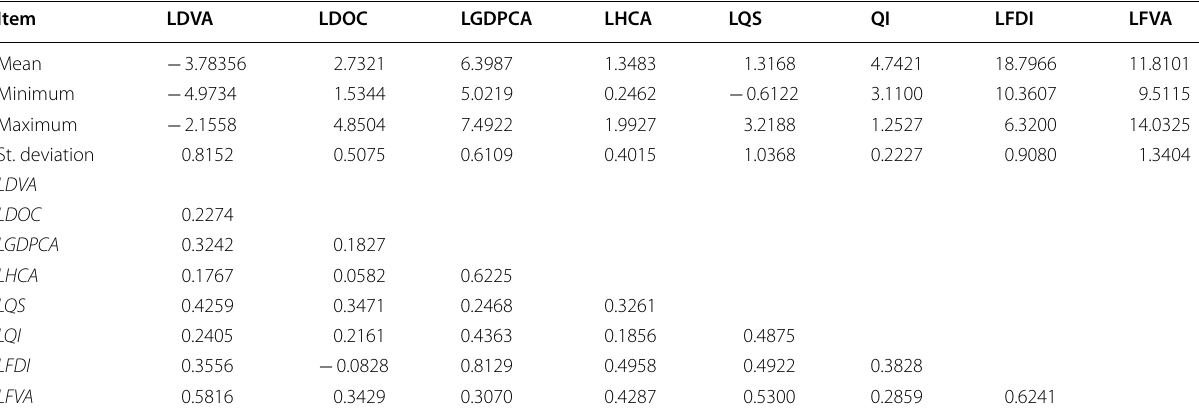
Table 3 Descriptive statistics and correlation of variables